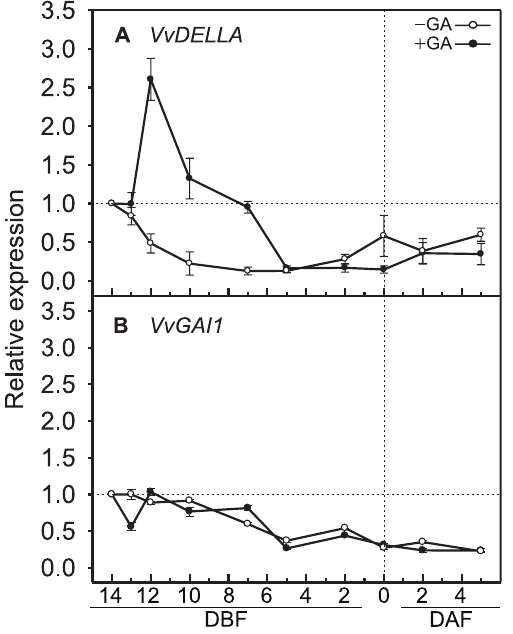
Figure 4. Transcriptional changes in two DELLA genes. ( A ) VvDELLA and ( B ) VvGAI1 in grapevine inflorescences with and without GA application. DAF, days after full bloom; DBF, days before full bloom. Quantitative reverse transcription-PCR was performed to measure the expression level of each gene using the comparative C T method. After normalization of each sample to the expression of the internal control VvActin1 , the expression of each gene relative to the 14 DBF sample was calculated. Bars are standard errors of the means from three independent experiments.